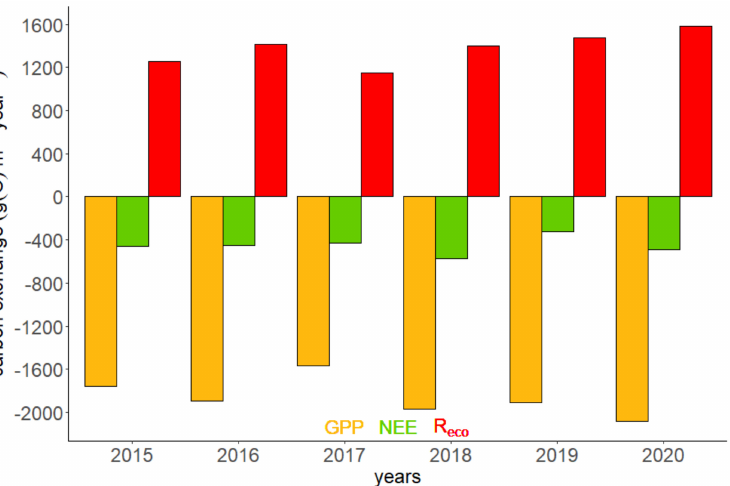
Figure 3. Annual totals of gross primary production (GPP), net ecosystem exchange (NEE) and ecosystem respiration (R eco ) for the measurement period 2015–2020 at the floodplain forest in Lanžhot, Czech